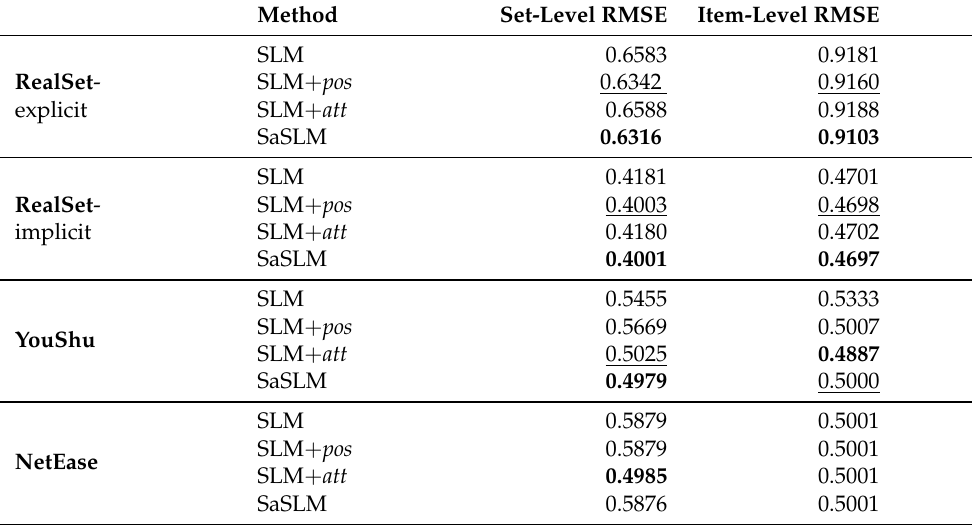
Table 6. Ablation study of